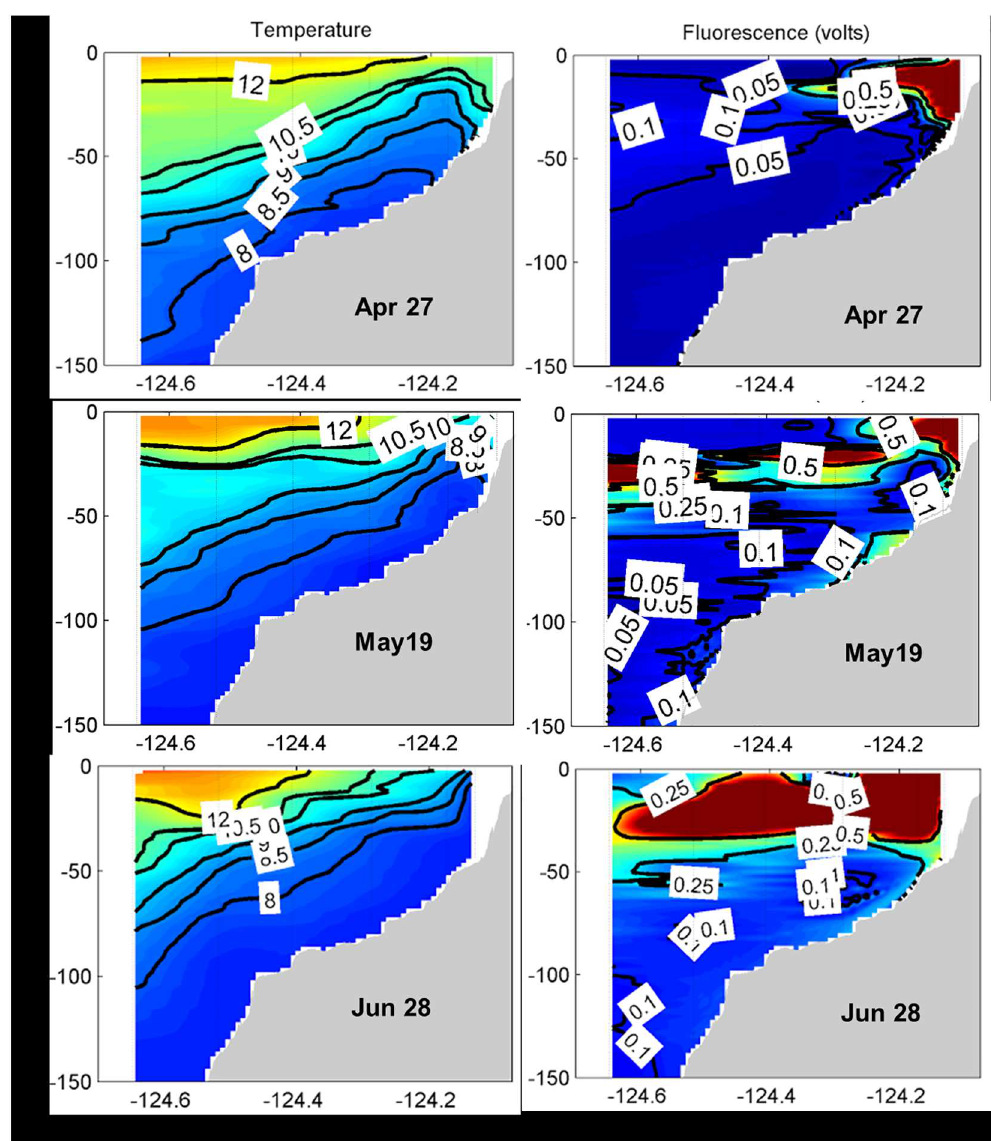
Fig 5. Vertical contours of temperature (˚C, left) and chlorophyll fluorescence (volts, right). Contour plots on three samplingsdates of April 27, May 19 and June 28 (the major PN bloom period in 2015) are shown for the Newport Hydrographic transect